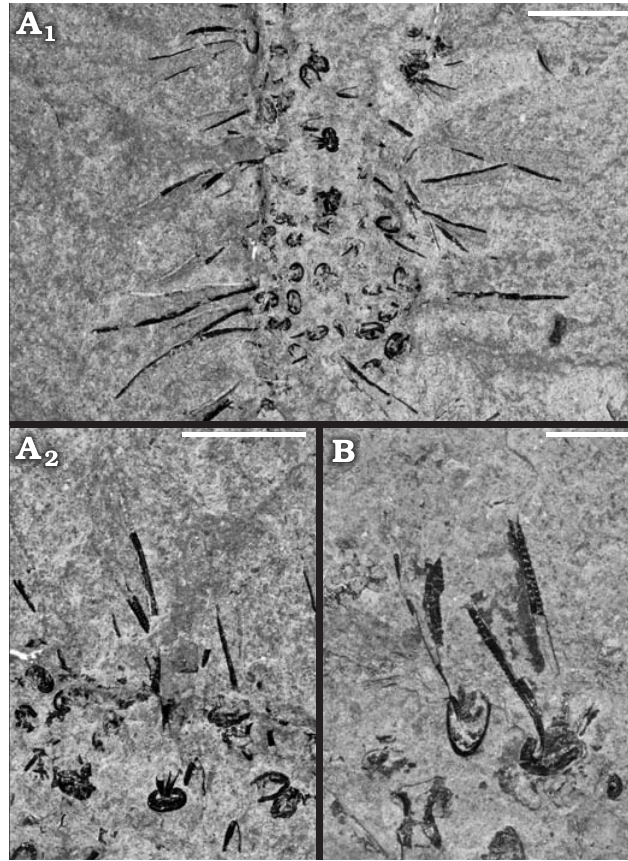
Fig. 6. Medusozoan cnidarian Sphenothallus sp. on a possible orthoconic cephalopod; from the Upper Ordovician (Katian 1–2) Utica Shale, Cap Santé, Québec, Canada. Light photographs of epibiontic tubes. A . MPEP1144.1, A 2 detail of A 1 . B . MPEP1144.2. Scale bars A 1 , 5 mm; A 2 , B, 3